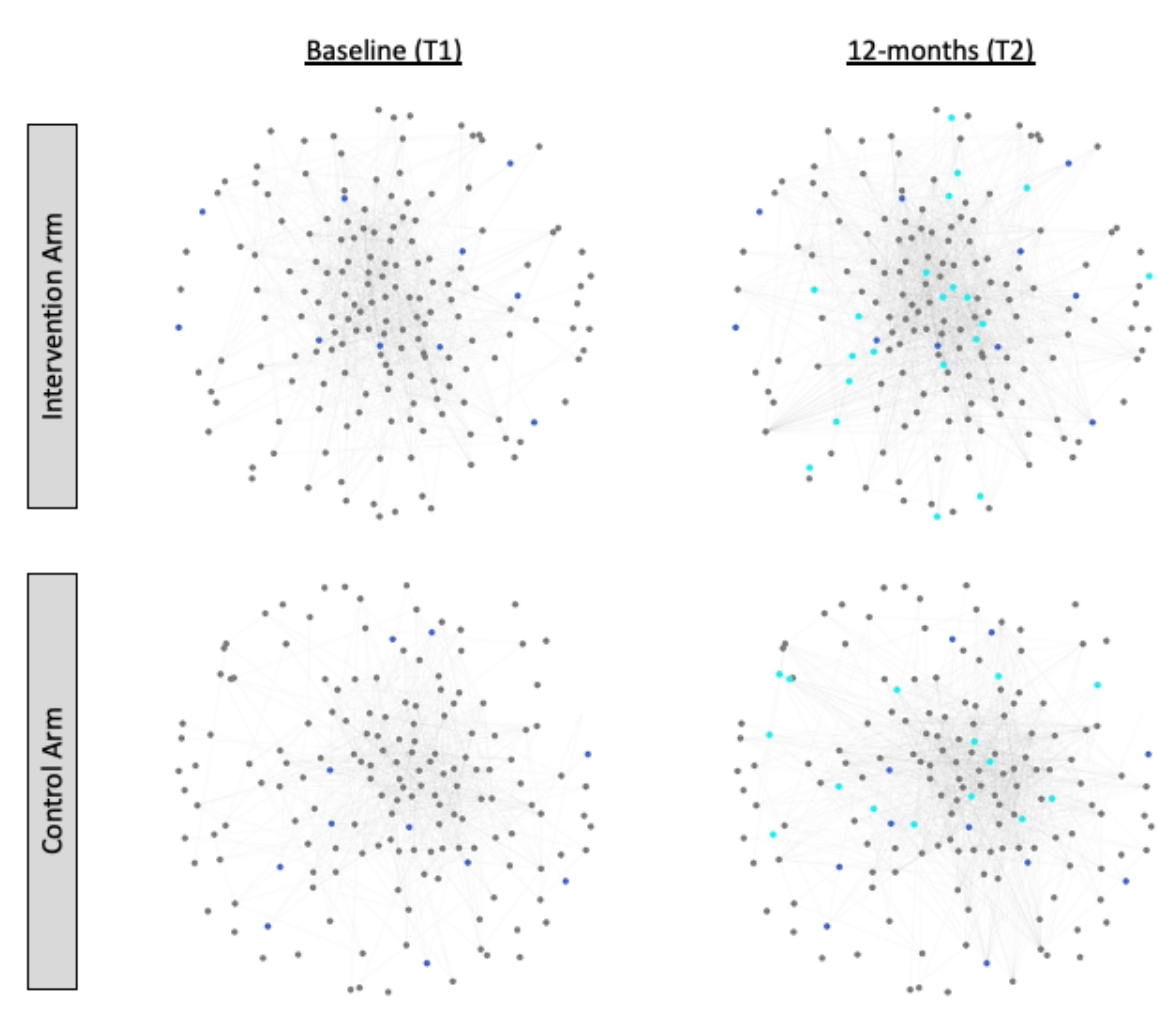
Figure 1. The Facebook friendship networks among intervention ( n = 174) and control arm ( n = 166) participants at baseline (T1) and 12-months (T2), with information about PrEP adoption status. Each circle (node) represents one study participant in either the intervention or control arm sub-samples. Circles are colored by their PrEP adoption status at each wave: grey denotes a study participant who was not a PrEP adopter, dark blue denotes a study participant who reported being on PrEP at baseline (T1), and aqua blue denotes a study participant who adopted PrEP at 12-months (T2). Visualizations were created in Python.